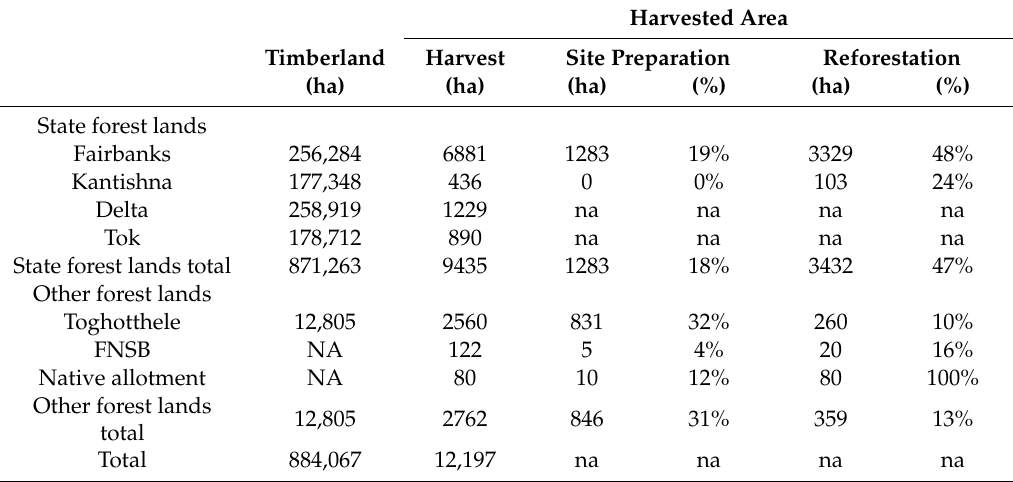
Table 6. Areas of timberland and harvest (ha), and area (ha) and % of harvested areas which received site preparation and reforestation in the study area for the period of 1972–2012. FNSB = Fairbanks North Star Borough